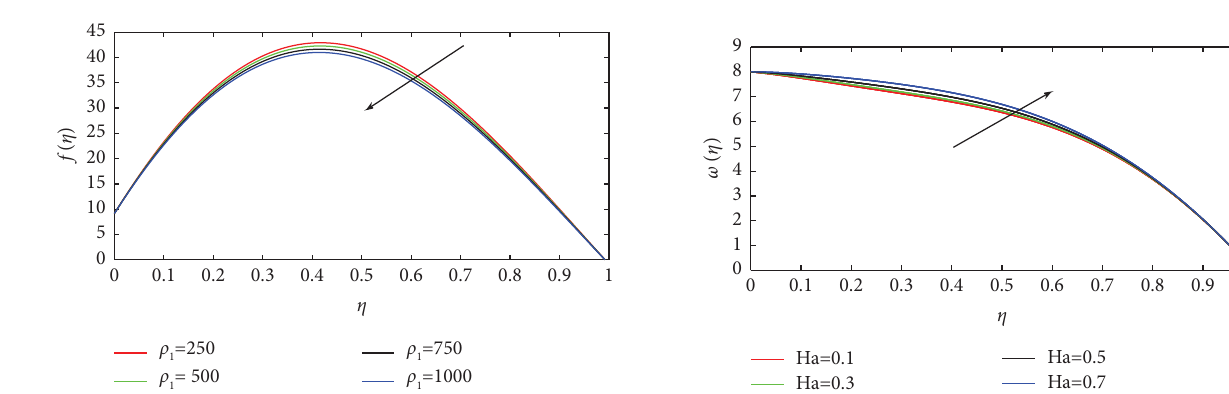
Figure 8: Velocity profles for the diferent values of ρ